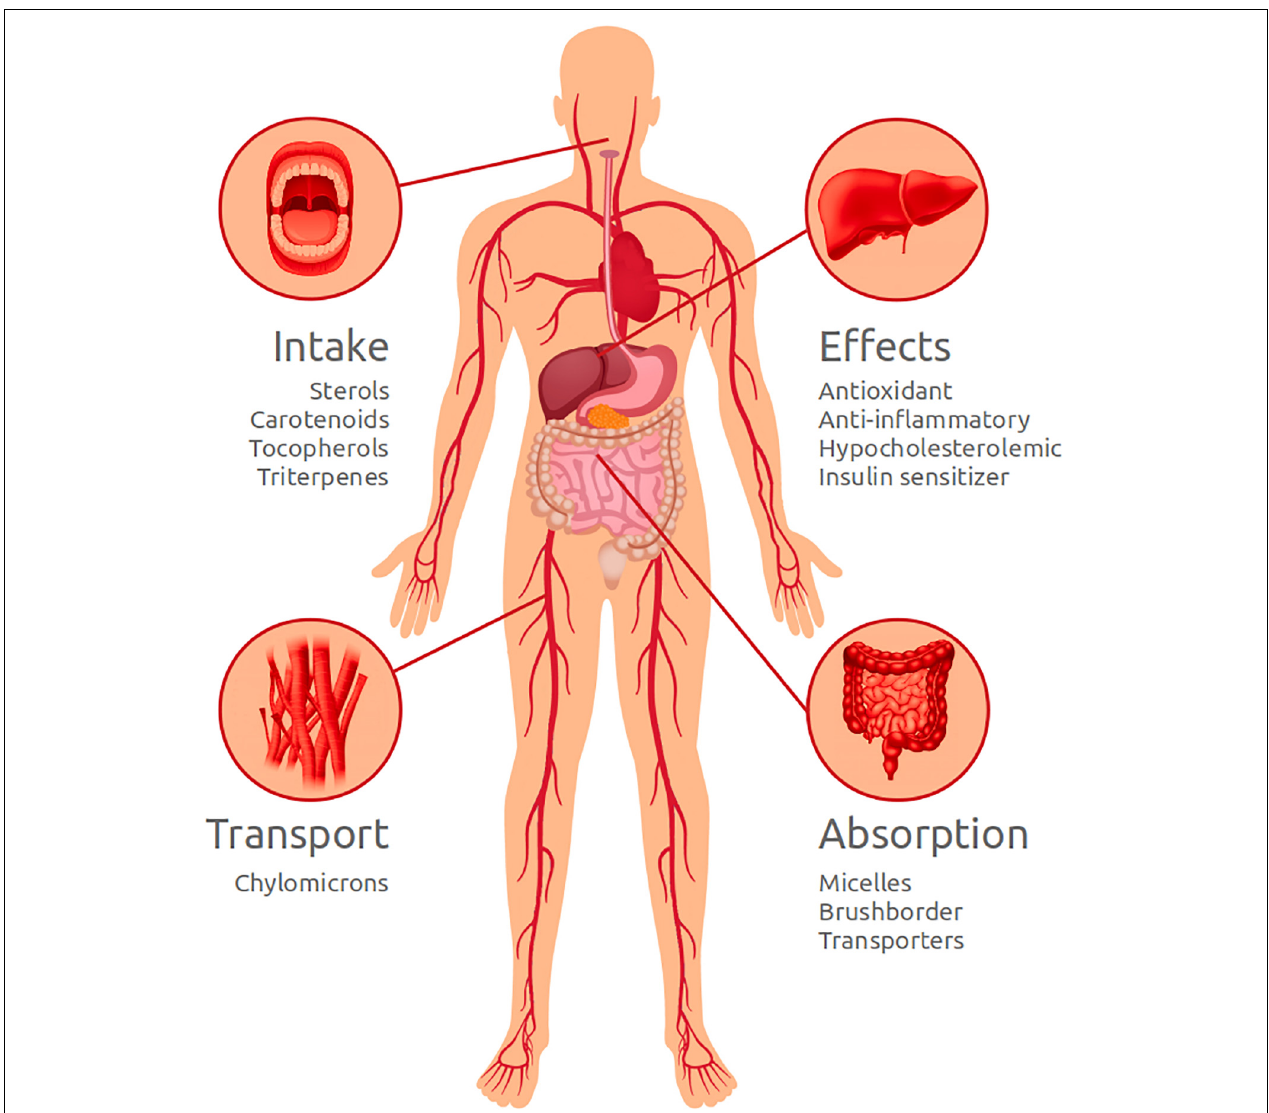
FIGURE 5 | Schematic drawing illustrating the main processes and effects that phytosterol, carotenoids, tocopherols, and triterpenes may have on human body.